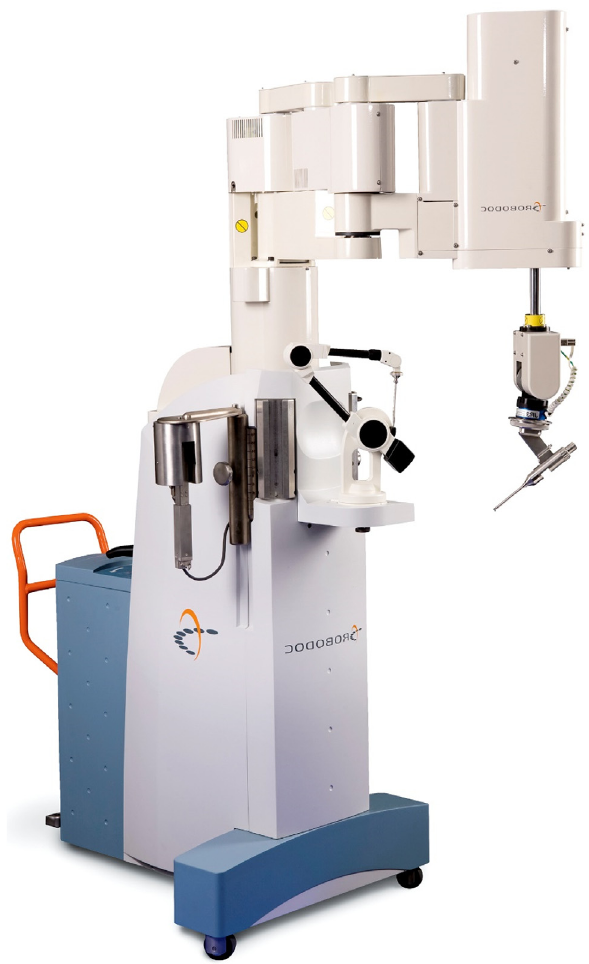
Figure 7. TSolution-One (cid:2) (Robodoc)